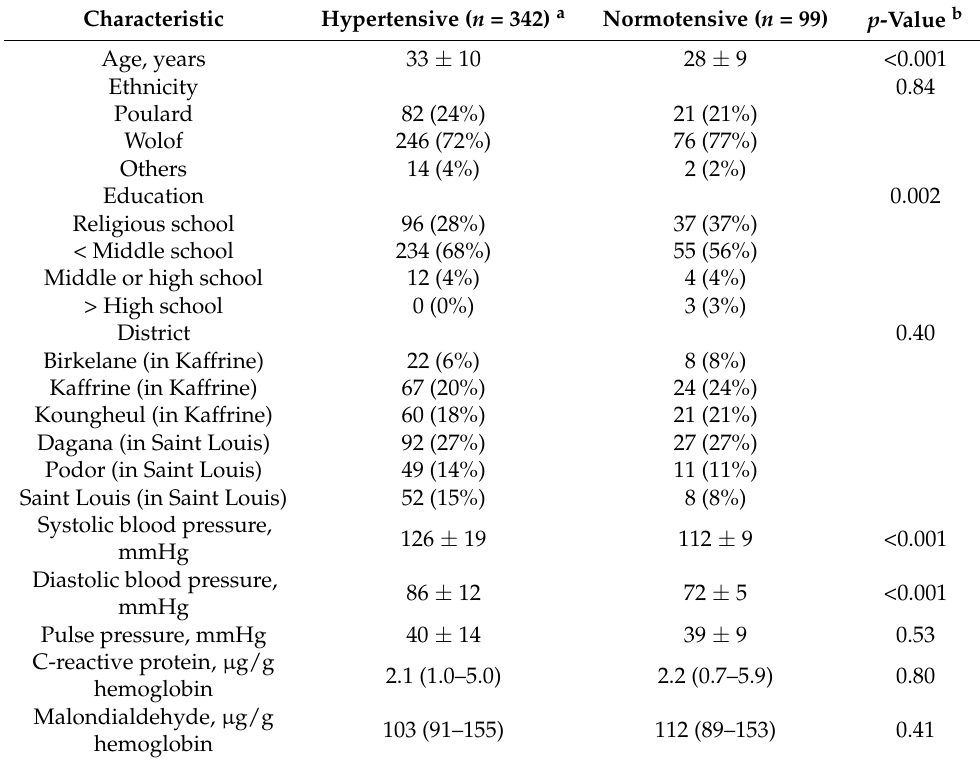
Table 1. Baseline characteristics of hypertensive and normotensive (excluded) participants.